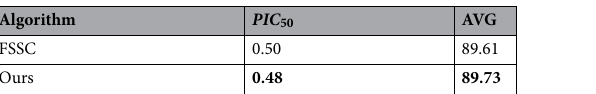
Table 2. Comparison of feature selection algorithms. AVG:ADMET property prediction average accuracy. Significant values are in [bold].